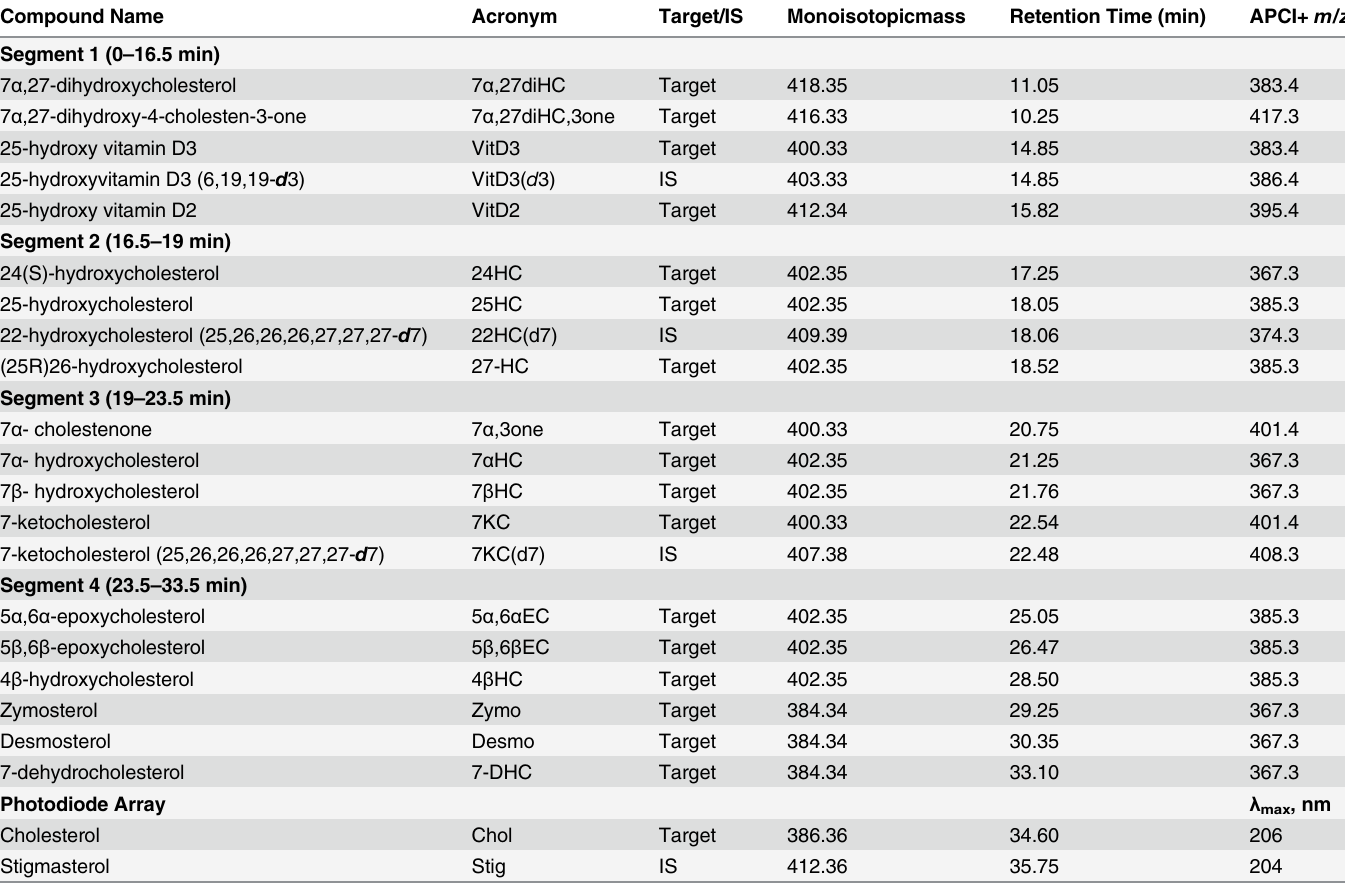
Table 1. Analyte systematic name, acronym and the selected ion monitoring (SIM) segment windows used for APCI + -MS detection and the wave- lengths for photodiode array detection. Compound